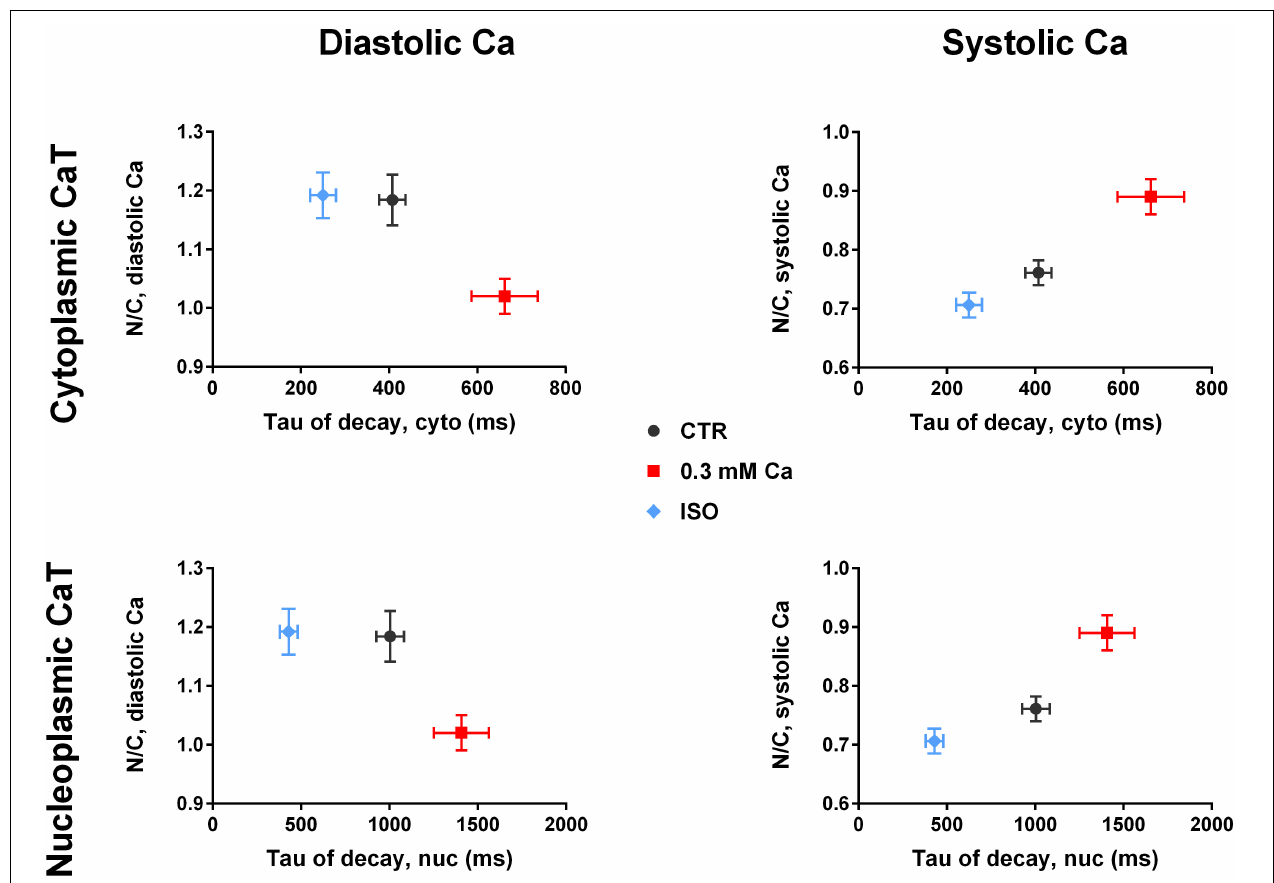
FIGURE 6 | Nuc-to-cyto ratios vs tau of decay. (Left panel) Diastolic N/C as a function of τ of decay of the cytoplasmic CaT (top) and of the nucleoplasmic CaT (bottom). Diastolic N/C decreases with increasing τ . (Right panel) Systolic N/C as a function of τ of decay of the cytoplasmic CaT (top) and of the nucleoplasmic CaT (bottom). Systolic N/C increases with increasing τ . Ca 0.3: n / N = 19/7, ISO: n / N = 30/7, CTR: n / N =